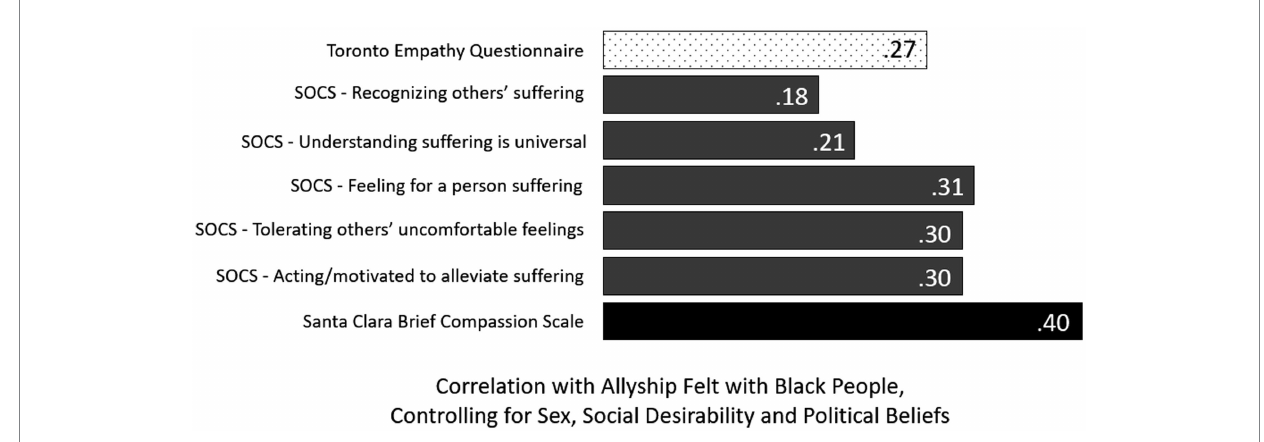
FIGURE 1 Partial correlations of empathy and compassion with felt allyship with Black People, controlling for sex, social desirability, and political beliefs. SOCS is the abbreviation for the Sussex Oxford Compassion for Others Scale and is used to refer to each of the five subscales of the